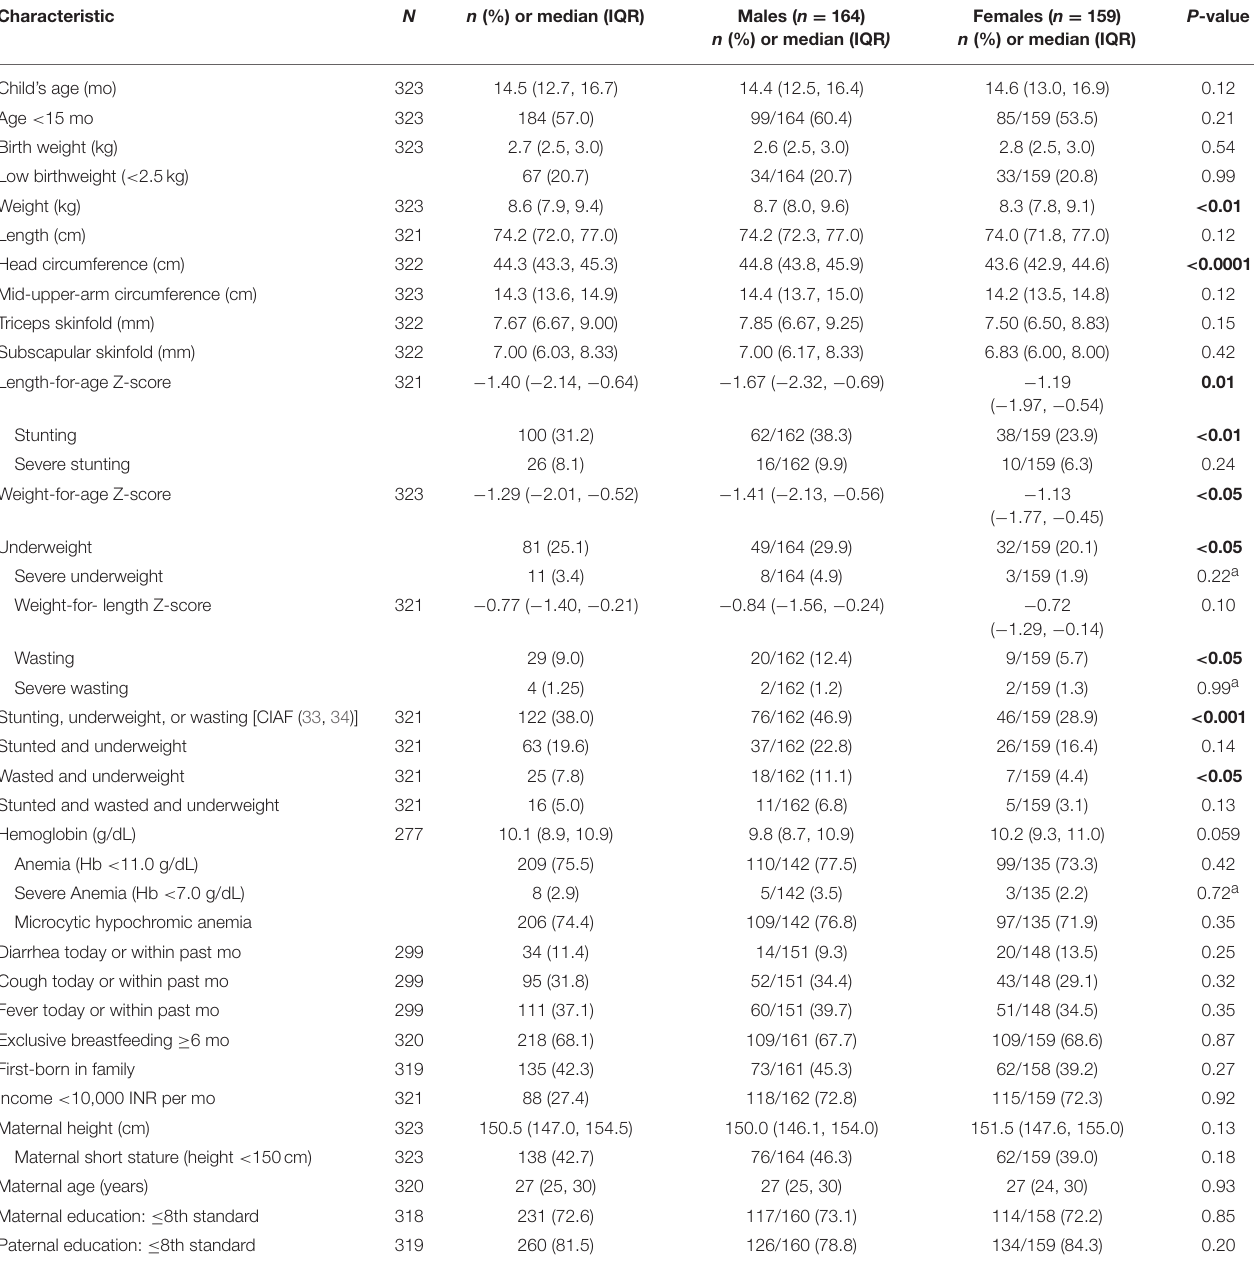
TABLE 1 | Characteristics of cohort ( N =